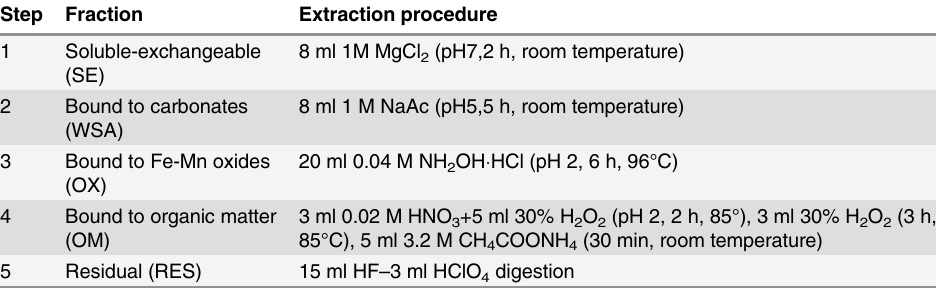
Table 2. Sequential extractions steps for Cd in contaminated